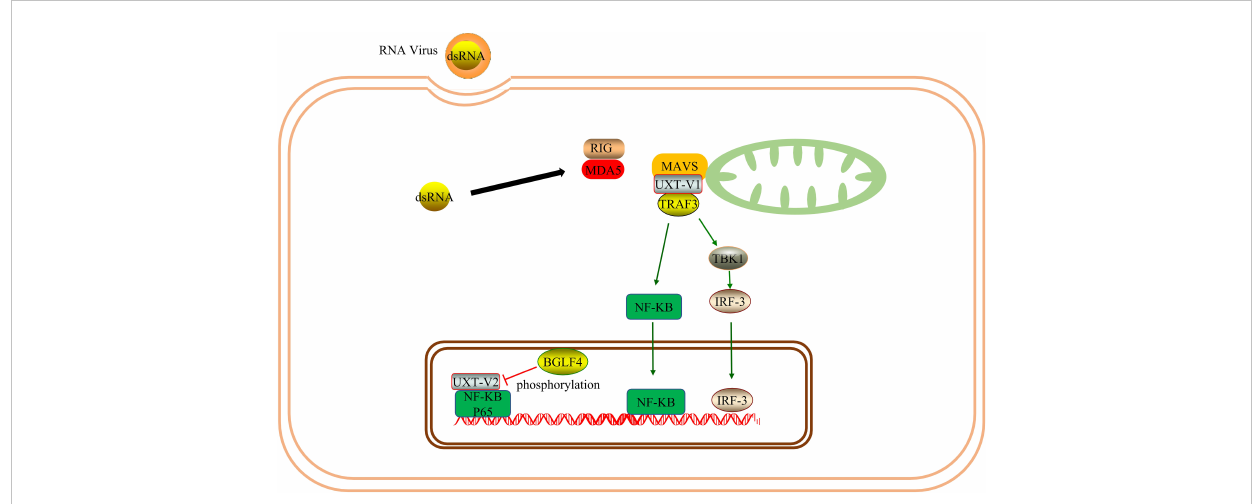
FIGURE 5 UXT promotes immune response: As one of the components of the MAVS signalosome, UXT-V1 promotes the nuclear translocation of IRF3 and NF- k B by binding to TRAF3, thus promoting innate immune response. UXT-V2 can be phosphorylated by BGLF4, disrupting its NF- k B enhanceosome